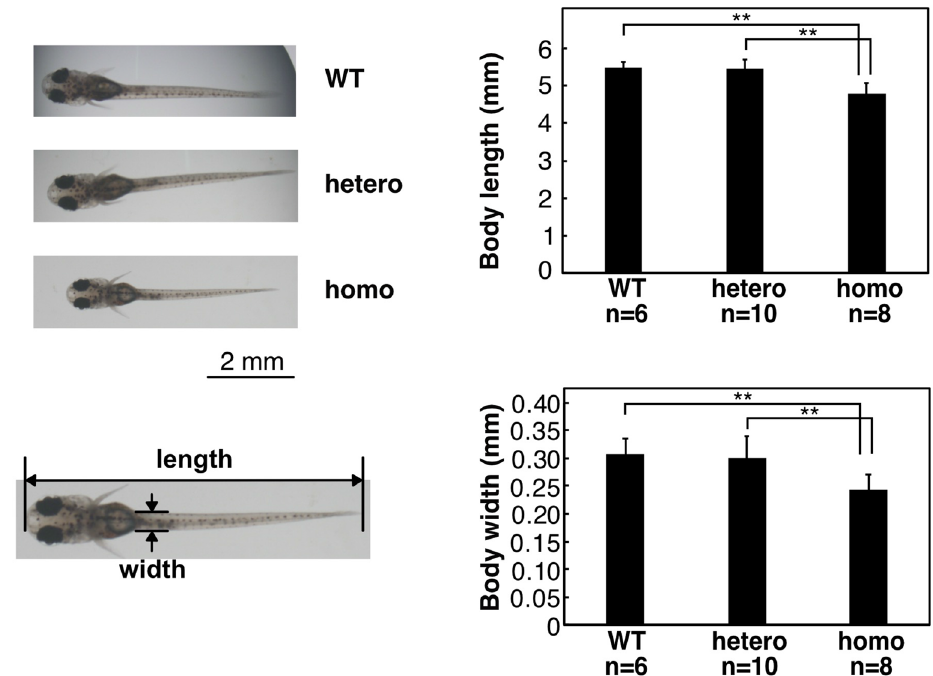
Figure 4. Body length of L304Q medaka at 14 dpf. Images of WT, hetero, and L304Q homo medaka fry at 14 dpf were observed under the microscope ( left ). The scale bars indicate 2 mm. The body lengths of medaka fry at 14 dpf were measured and the data are summarized in a bar graph ( right ). n, the number of fry measured. The bars represent standard deviations obtained for the indicated numbers of fry. **indicates p < 0.005.